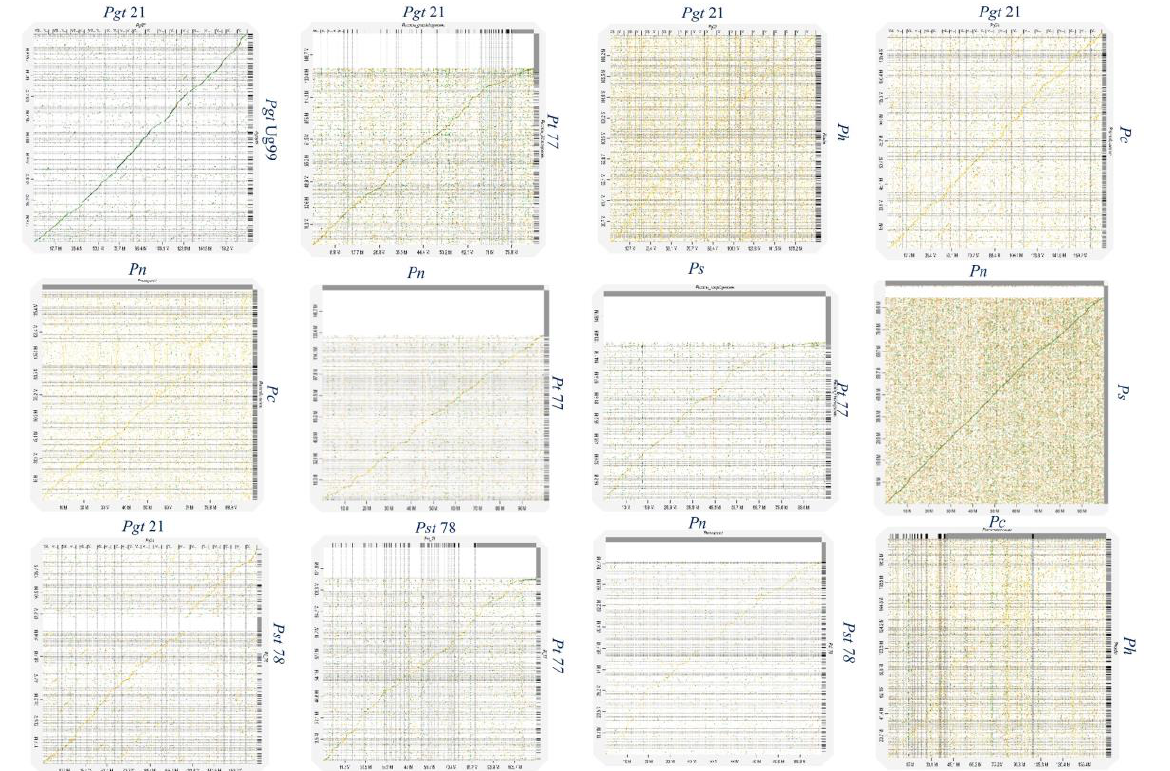
Figure 3. Synteny plots of P. novopanici genome with other Puccinia genomes . Figures represent